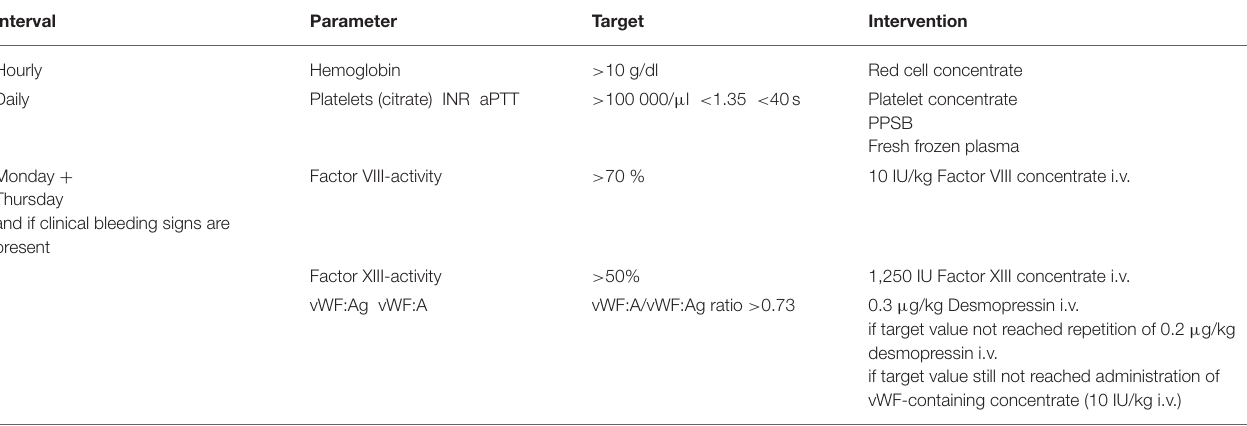
TABLE 1 | Routine blood drawings for the determination and treatment of acquired bleeding disorders during vvECMO in our department. Interval